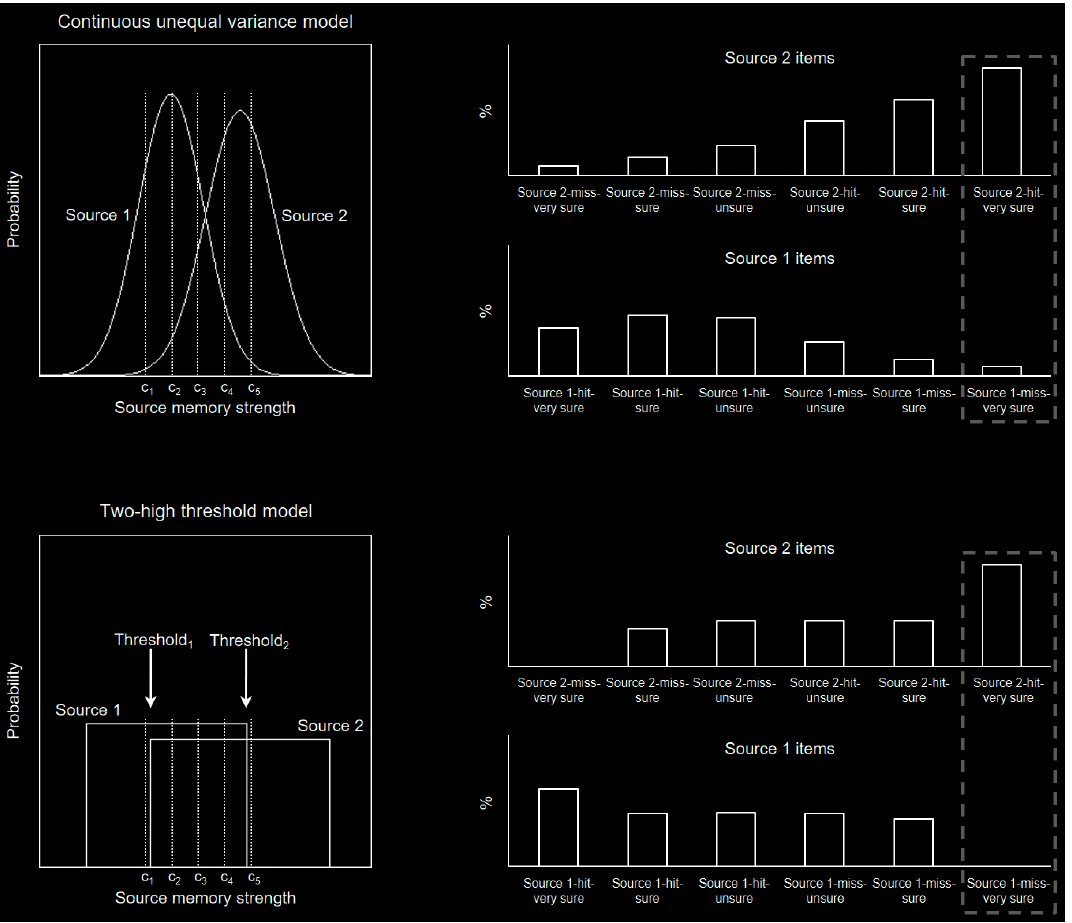
Figure 1. Models of recollection and event distributions. Top , continuous unequal variance model and corresponding percentage for each event type. Bottom , two-high threshold model and corresponding percentage for each event type.